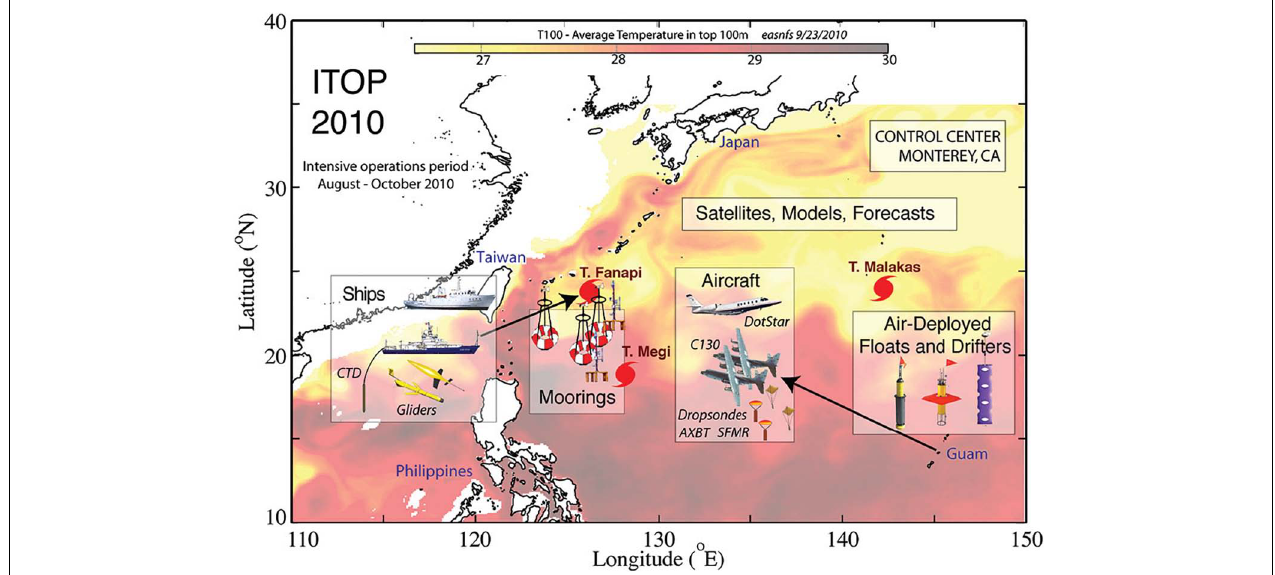
FIGURE 10 | Background color map of average temperature for the upper 100 m (T100) from the East Asia Seas Nowcast/Forecast System on 23 September, 2010. Overlaid are graphical representations of the ITOP operations area, experimental tools, and strategy. Locations of the three major ITOP storms at the time of maximum sampling are shown by storm symbols. Figure originally from D’Asaro et al. (2014), © American Meteorological Society. Used with permission.